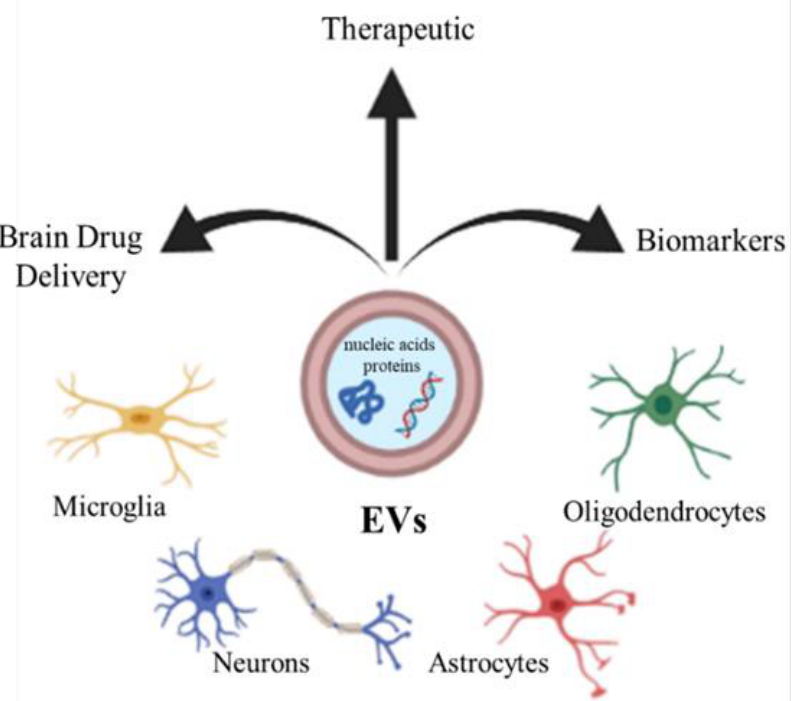
Figure 1. CNS cells (microglia, neurons, astrocytes, oligodendrocytes) release extracellular vesicles (EVs), which can be used as biomarkers, therapy, and drug vectors to the brain. Furthermore, EVs such as exosomes present good biocompatibility, low immuno- genicity, and can easily pass through the BBB. Several studies have shown the therapeutic potential of EVs from different cellular sources against MS [25] (Figure 2).